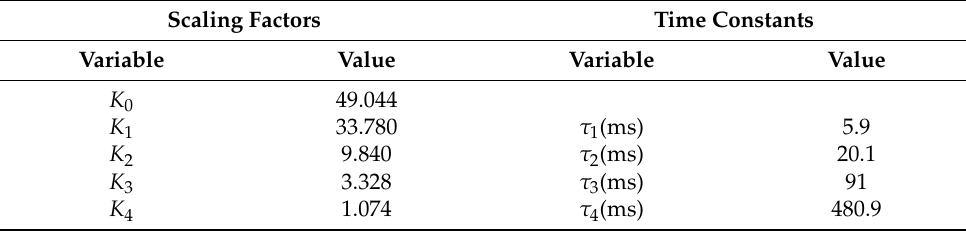
Figure 3. Functional Block Diagram implementing the transfer function in (11). Table 1. Values of scaling factors and time constants of the FBD in Figure